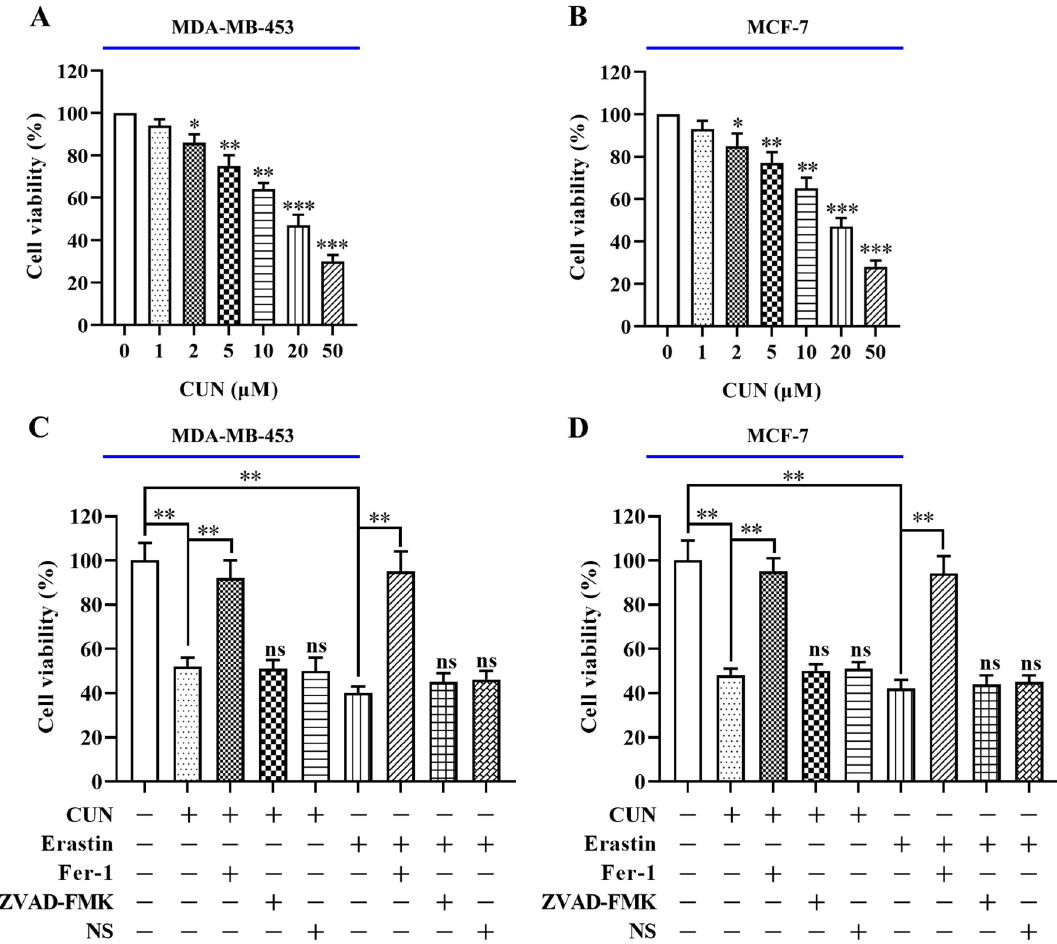
Fig 1. Treatment with CUN upregulates erastin-induced ferroptosis in BC cells. A and B: BC cells were treated with CUN at 0, 1, 2, 5, 10, 20 and 50 μ M for 48 h. The CCK-8 assay was used to assess cell viability. C and D: BC cells were preincubated with various inhibitors, including ZVAD-FMK (50 μ M), NS (50 μ M), ferrostatin-1 (50 nM) or erastin (10 nM) for 2 h followed by CUN (20 μ M) treatment for 48 h. The CCK-8 assay was performed to detect cell viability in both MDA-MB-453 and MCF-7 cells. Each data point is expressed as mean ± SEM of 3–5 independent tests. �� P < 0.01, ��� P < 0.001. CUN, curcumin; BC, breast cancer; CCK-8, cell counting kit-8; NS, necro-sulfonamide; SEM, standard error of the mean.